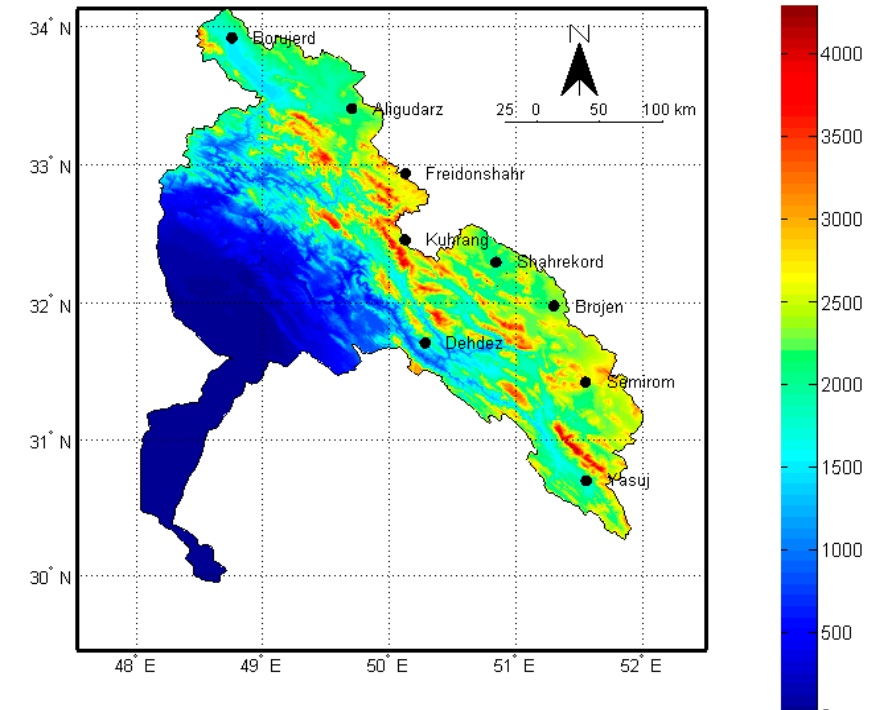
Figure 2. Digital elevation model and distribution of the applied synoptic stations across the Basin.